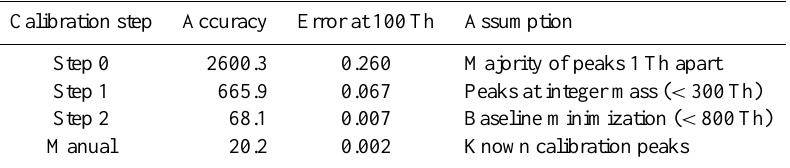
Table 2. Mass accuracy (ppm) of each calibration step. For clarity also the error (Th) at 100Th and assumption made at each step are reported.